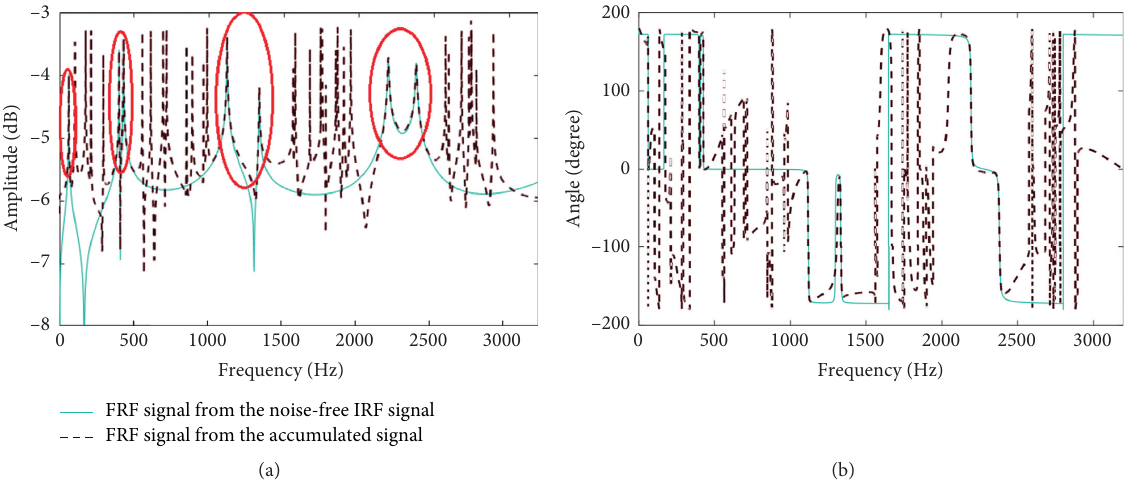
Figure 5: Noise reduction result of the component signal accumulation. (a) Energy spectrum. (b) Phase